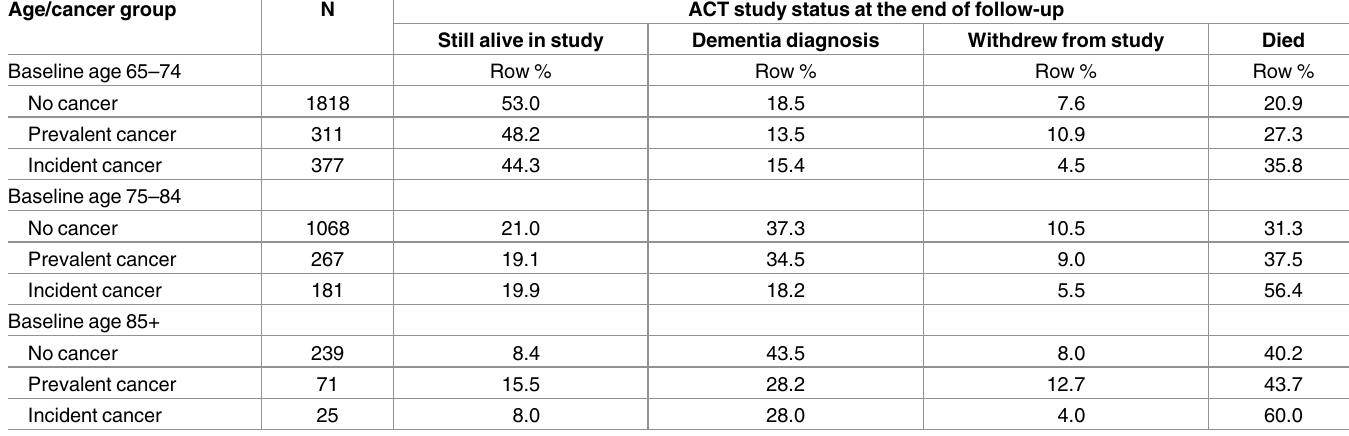
Table 4. ACT follow-up status by age at enrollment in the ACT study and final cancer exposure group. This table shows the proportionof peopleby ACT study follow-upstatus (still alive, diagnosedwith dementia, withdrewfrom the ACT study, or died) stratified by baselineage groups and cancer exposure group. Abbreviations include: ACT (Adult Changesin